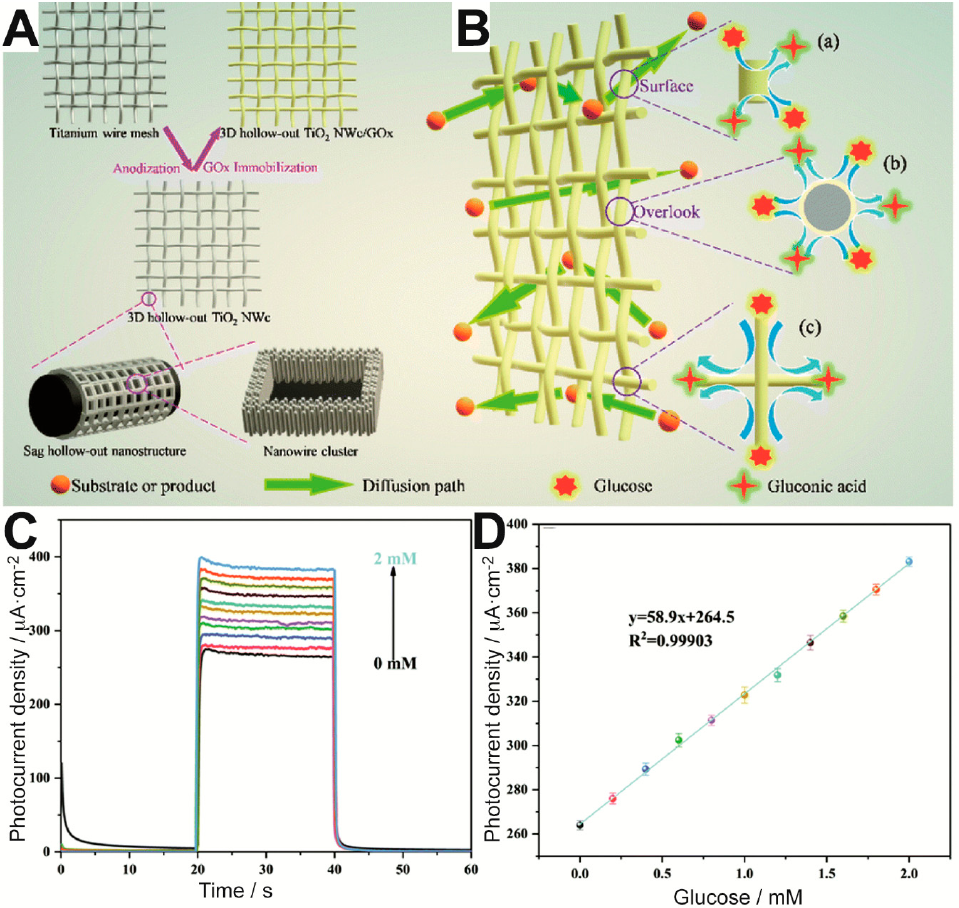
Figure 3. Schematic of ( A ) the preparation of 3D hollow-out TiO 2 NWc/GOx electrode and ( B ) glucose detection on the mesh electrode. Insets (a–c) show that the 3D network structure allows GOx to perform catalysis on a high surface. ( C ) Photocurrent density response over time of 3D hollow-out TiO 2 NWc/GOx in the presence of increasing concentrations of glucose. ( D ) Calibration plot. Adapted from [57] with permission from The Royal Society of Chemistry.